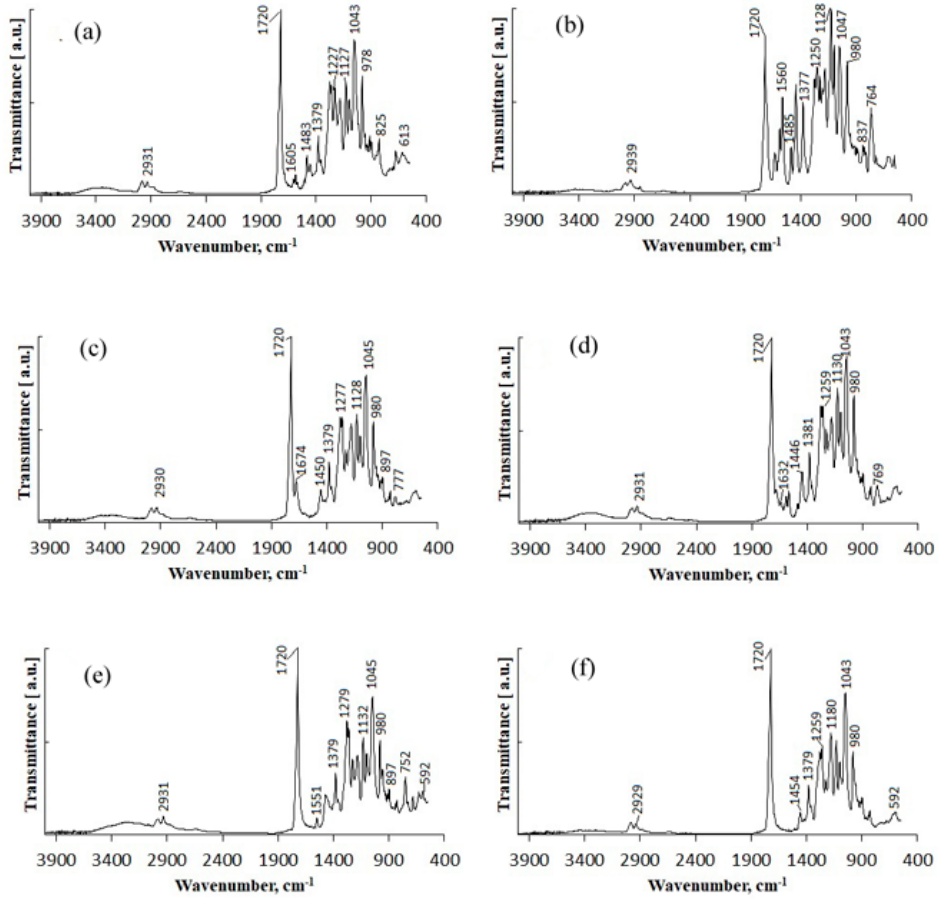
Figure 7. IR spectra of fungicide formulations: (a)—P(3HB)/wood flour/difenoconazole; (b)— P(3HB)/wood flour/azoxystrobin; (d)—P(3HB)/wood flour/azoxystrobin + mefenoxam; (e)—P(3HB)/wood flour/prothioconazole; (f)—P(3HB)/wood